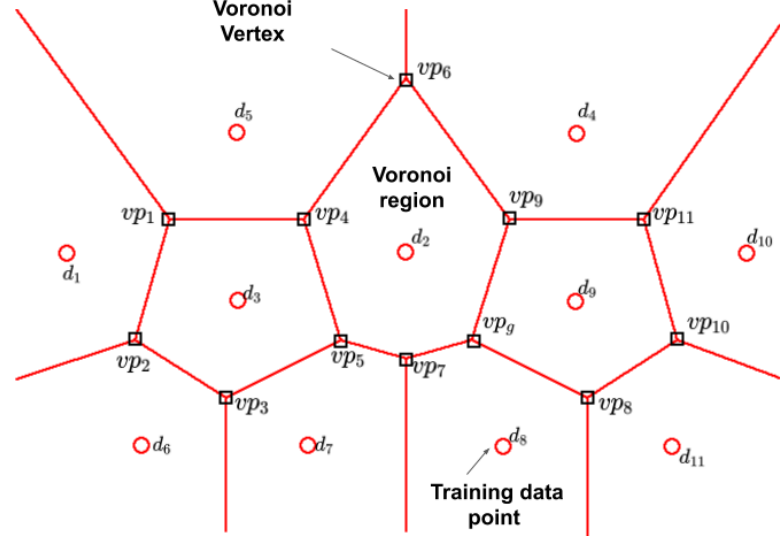
Figure 2. Voronoi plane diagram